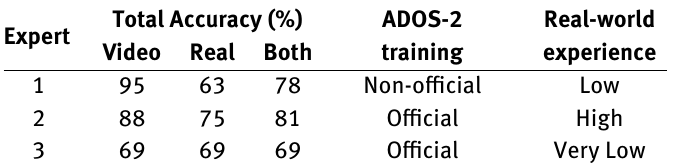
Table 2: Accuracy results per participant across the two studies.